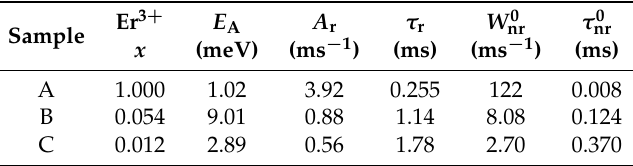
Table 2. Summary of the fitting parameters to reproduce the temperature dependence of τ slow depicted in Figure